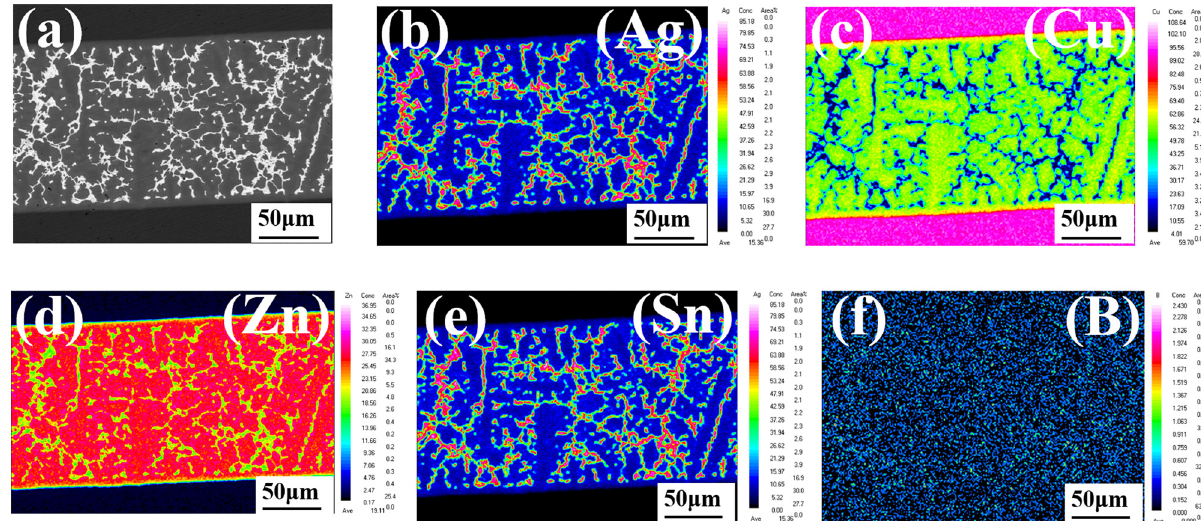
Figure 4: Surface scan distribution of the joint with 2% B. ( a ) Cross - sectional morphologies of the joint, ( b ) Ag, ( c ) Cu, ( d ) Zn, ( e ) Sn, and ( f ) B.